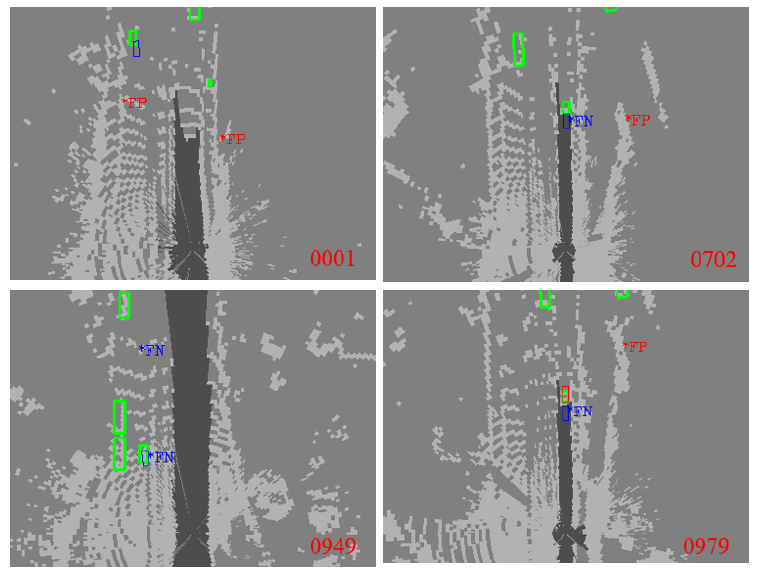
Figure 10. Judgment results of perception effectiveness: the judgment is correct. The judgment and verification are invalid after matching and verifying with the ground